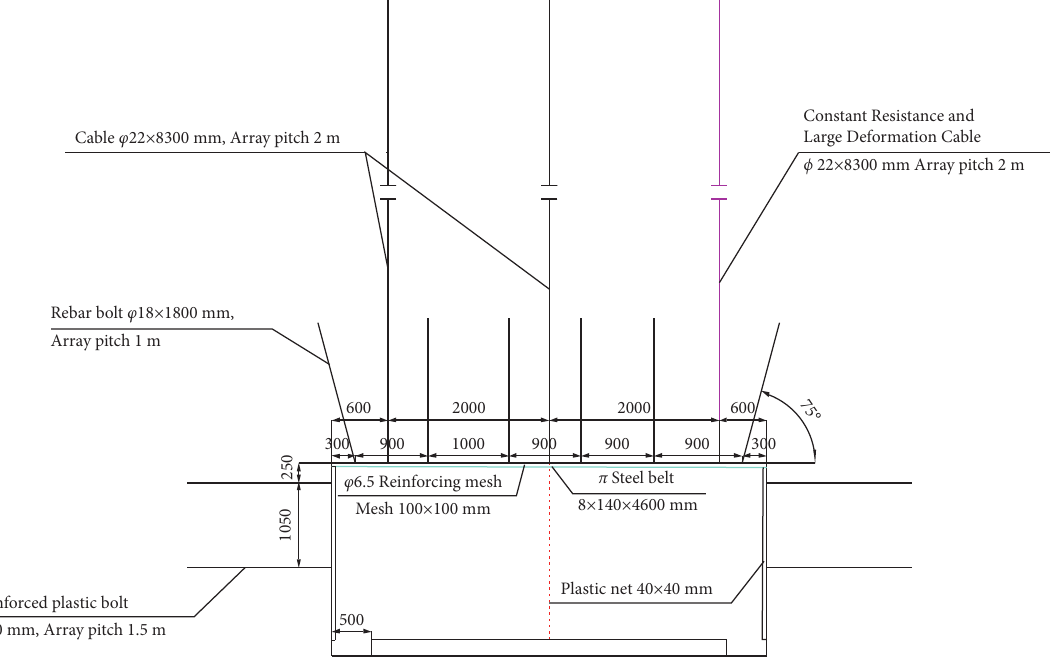
Figure 17: Design section of trough support.